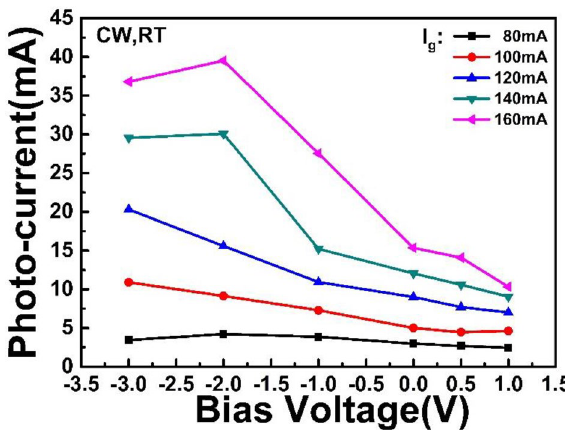
Figure 10. Photocurrent versus bias voltage under different I g